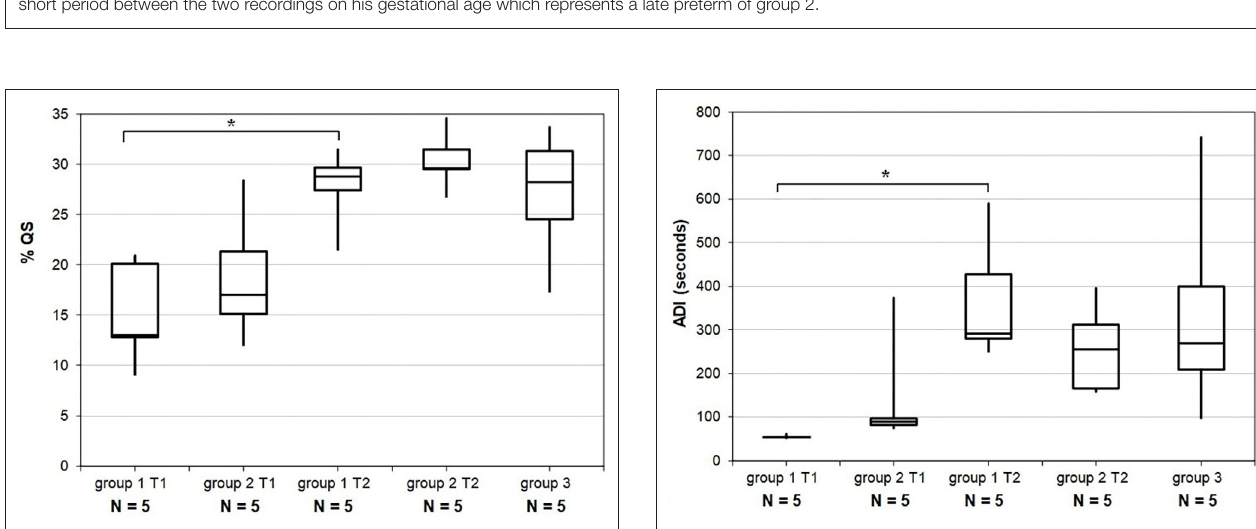
of time spent in QS and ADI spent in QS increased as a function of PMA. The temporal organization of QS appears correlated with PMA and depends on postnatal maturation